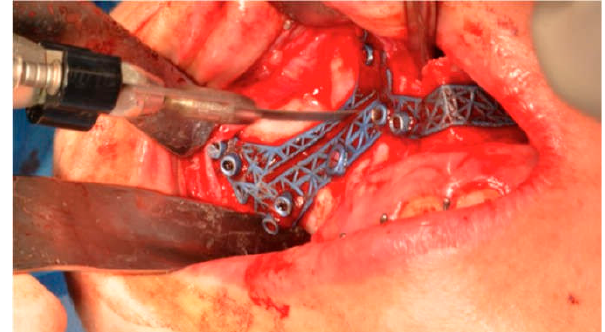
Figure 8. The osteotomy in the Le Fort I plane identified by the cutting guide.